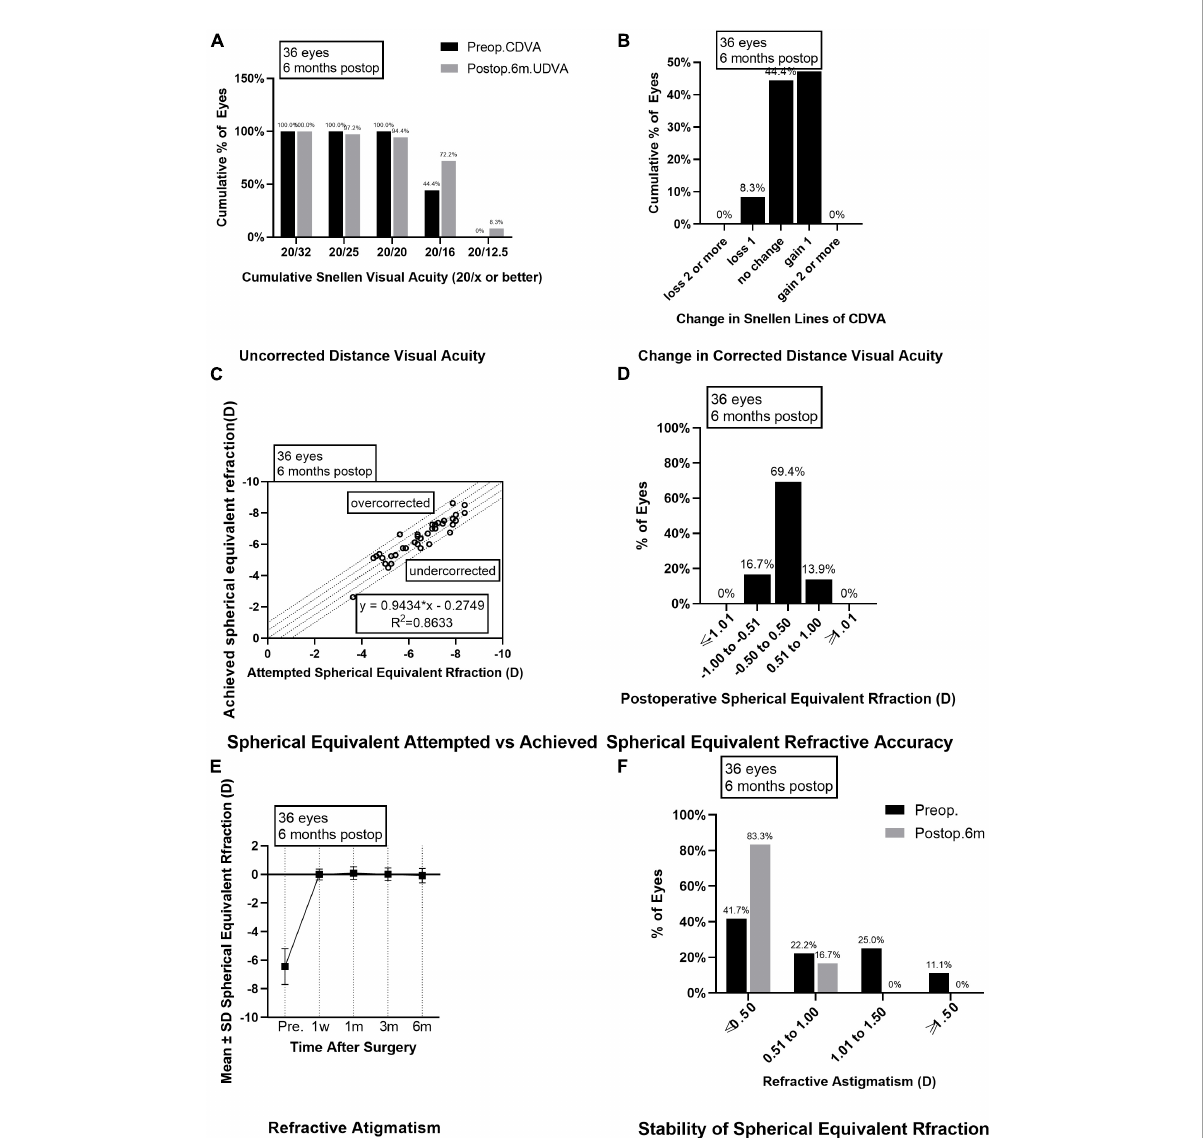
FIGURE1 Outcomes of group A after SMILE surgery. (A) Cumulative percentage of preoperative CDVA and postoperative UDVA in group A at 6 months follow-up; (B) Change in CDVA in group A at 6 months follow-up; (C) Achieved versus attempted change in SE at 6 months follow-up in group A; (D) Accuracy of SE refraction in group A at 6 months follow-up; (E) Stability of SE in group A at 1 week, 1 month, 3 months, and 6 months after surgery; (F) The percentage of preoperative postoperative refractive astigmatism in group A at 6 months follow-up. CDVA, corrected distance visual acuity; UDVA, uncorrected distance visual acuity; SE, spherical equivalent.